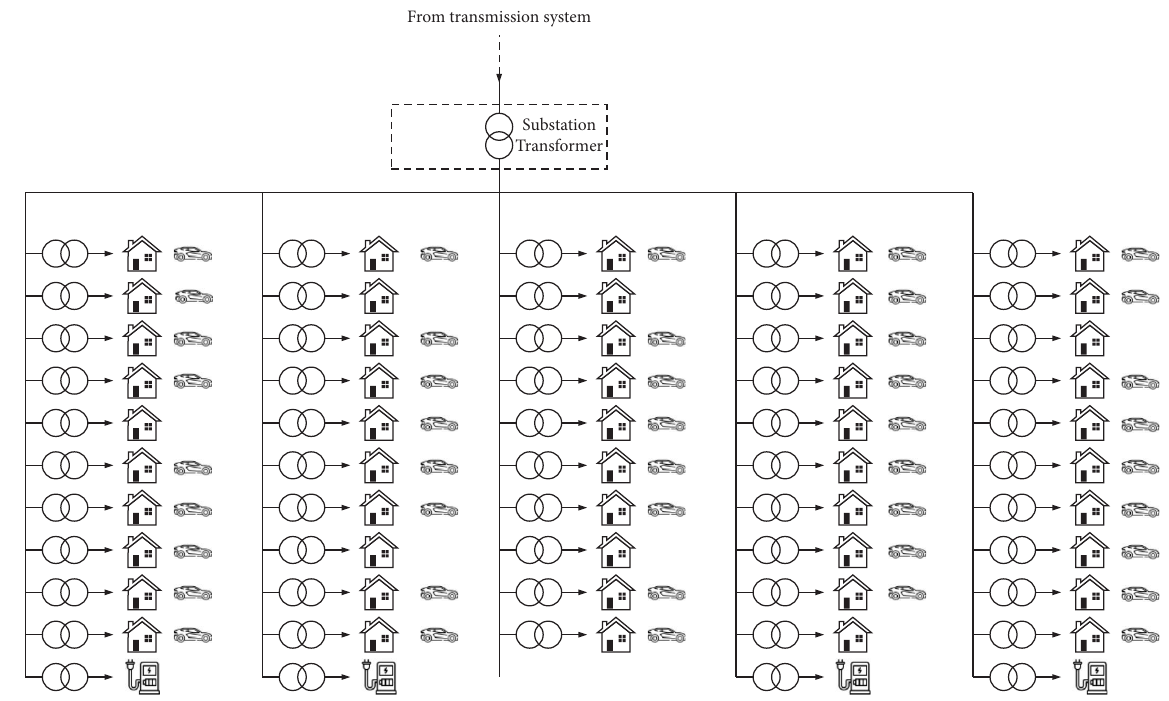
Figure 9: Conceptual system overview for the study